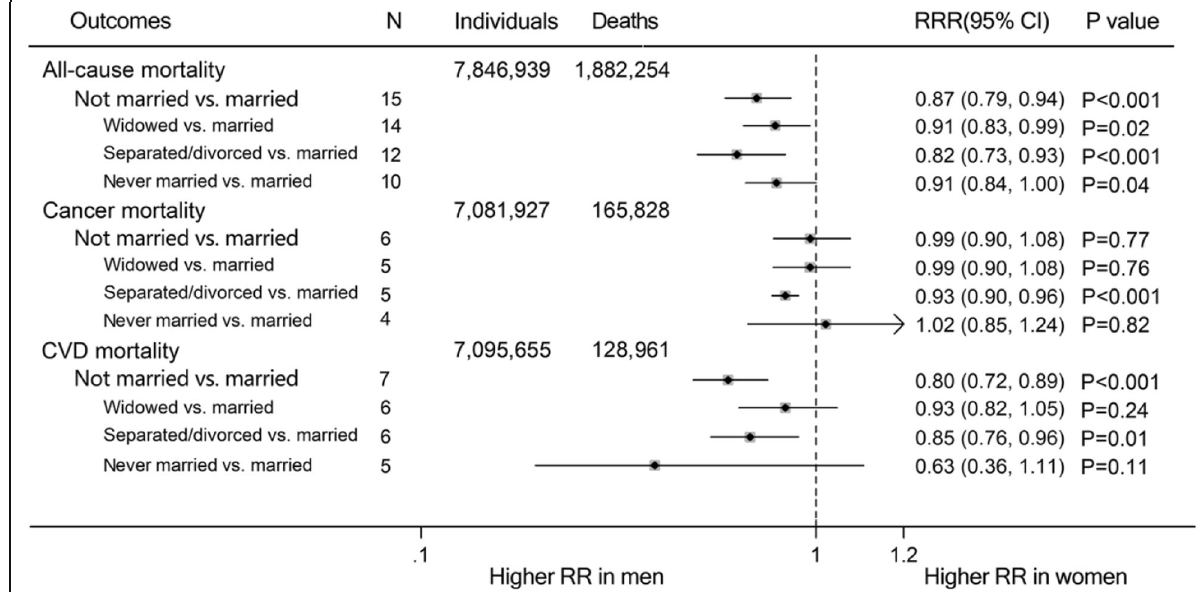
Fig. 4 Pooled women-to-men ratios of relative risk (RRRs) for risk of all-cause, cancer and CVD mortality comparing non-married people to married people of three specific types (widowed, separated/divorced or never married). The size of the gray squares do not indicate the relative weight of each estimate